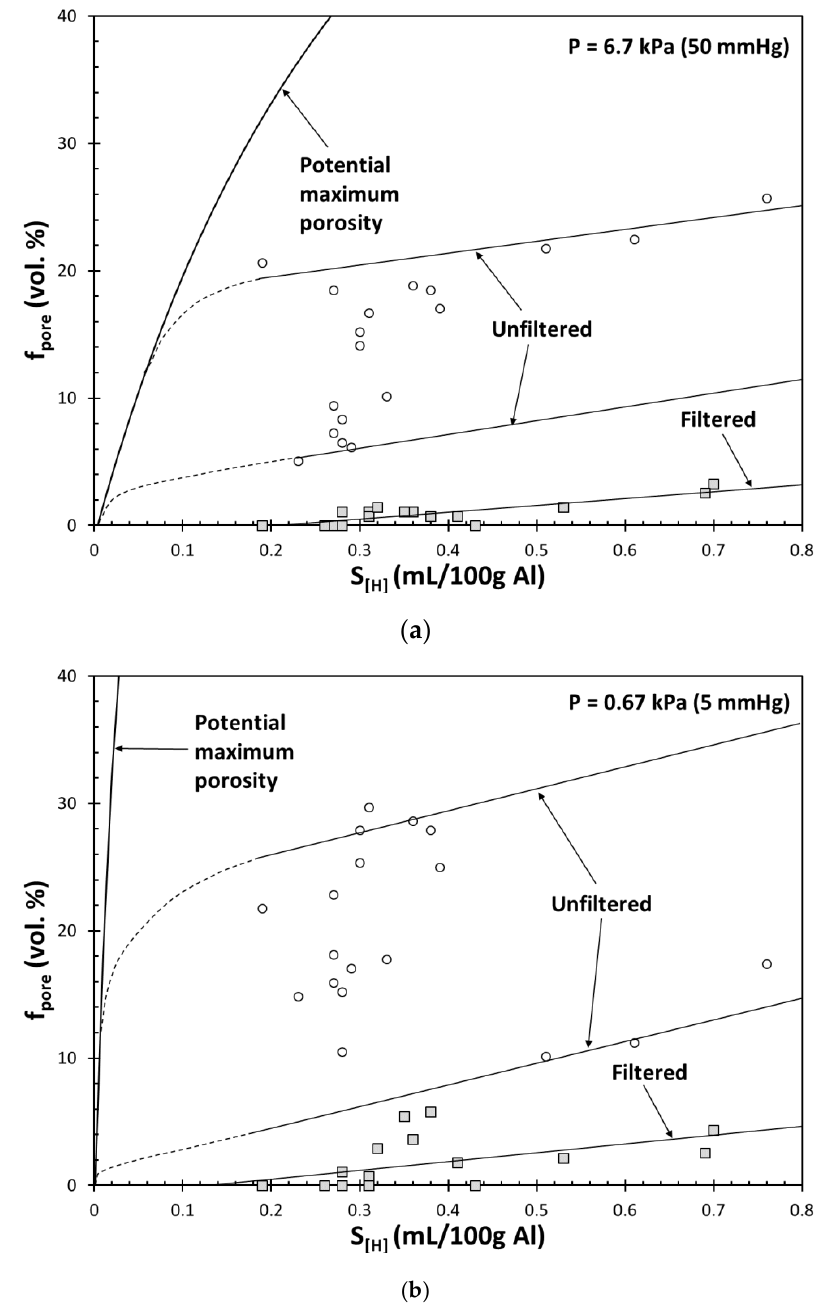
Figure 9. The effect of deep bed filtering and hydrogen content on ( a ) the density, and ( b ) the volume percent of pores in an Al-Cu alloy solidified under a reduced pressure of 6.7 kPa (data from Ref. [87]). Note that, for specimens that solidified under atmospheric pressure, a maximum hydrogen supersaturation of 14.9 was found. For specimens under reduced pressure, however, much higher supersaturation levels are reported. It should be noted that these numbers should be taken as “missing” data, i.e., pores did not form, and hence the liquid metal withstood the supersaturation and any negative pressure formed during solidification. Therefore, the data should be treated as censored, analogous to “run-outs” in fatigue testing. Hence, aluminum can accommodate large